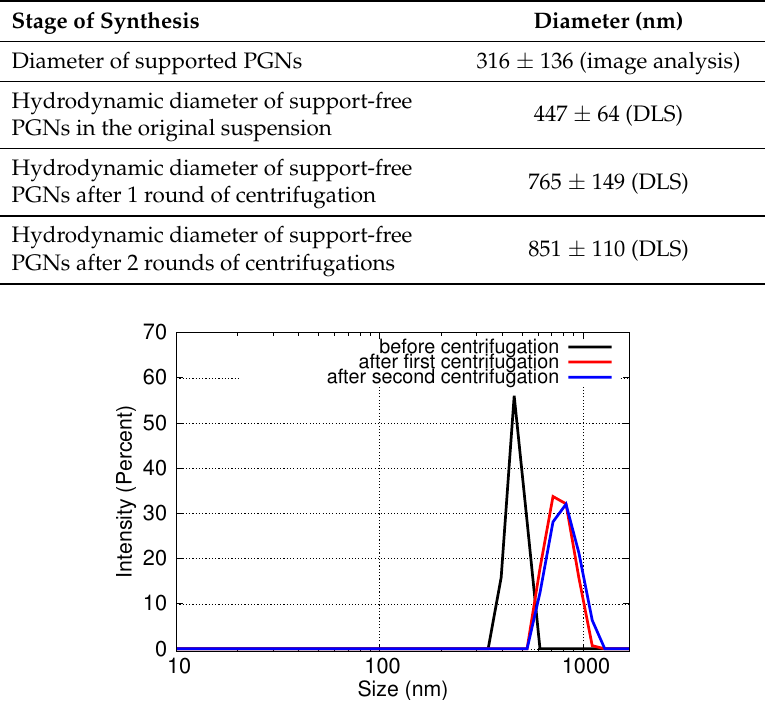
Figure 4. Particle size distribution curves of support-free PGNs measured in their suspensions by DLS after each recovery step. The size distribution of PGNs is altered in the first centrifugation step, but the second centrifugation does not affect further the size of the